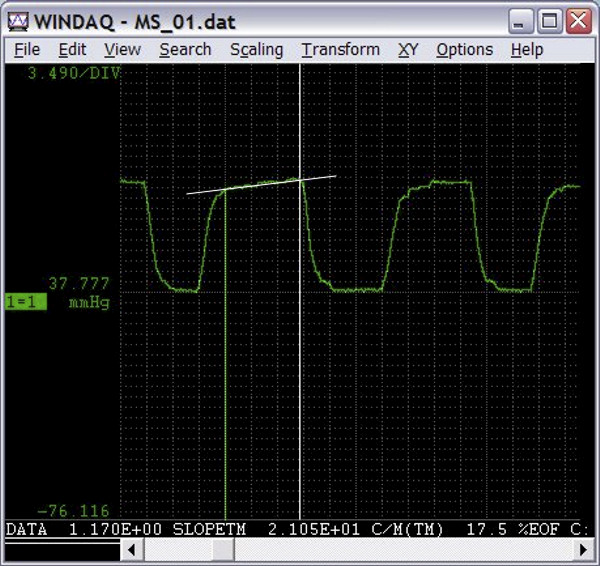
The example of capnographic wave analysis using WinDaq software. Screenshot of WinDaq windows showing the measurement of slope3 of the typical capnographic wave.